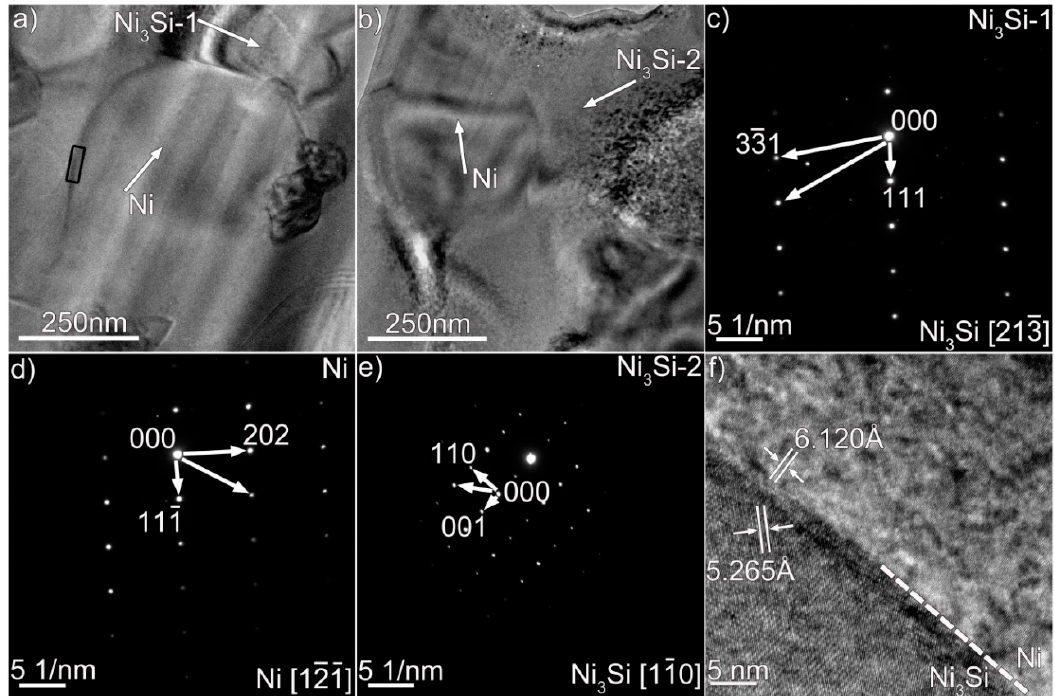
Figure 5. ( a , b ) Bright-field TEM micrographs of Ni 3 Si and Ni in the coating, ( c , d ) SAED patterns of Ni 3 Si and Ni in ( a ), ( e ) SAED pattern of the Ni 3 Si in ( b ), and ( f ) HRTEM image of the Ni 3 Si / Ni interface enclosed in black box in ( a ).